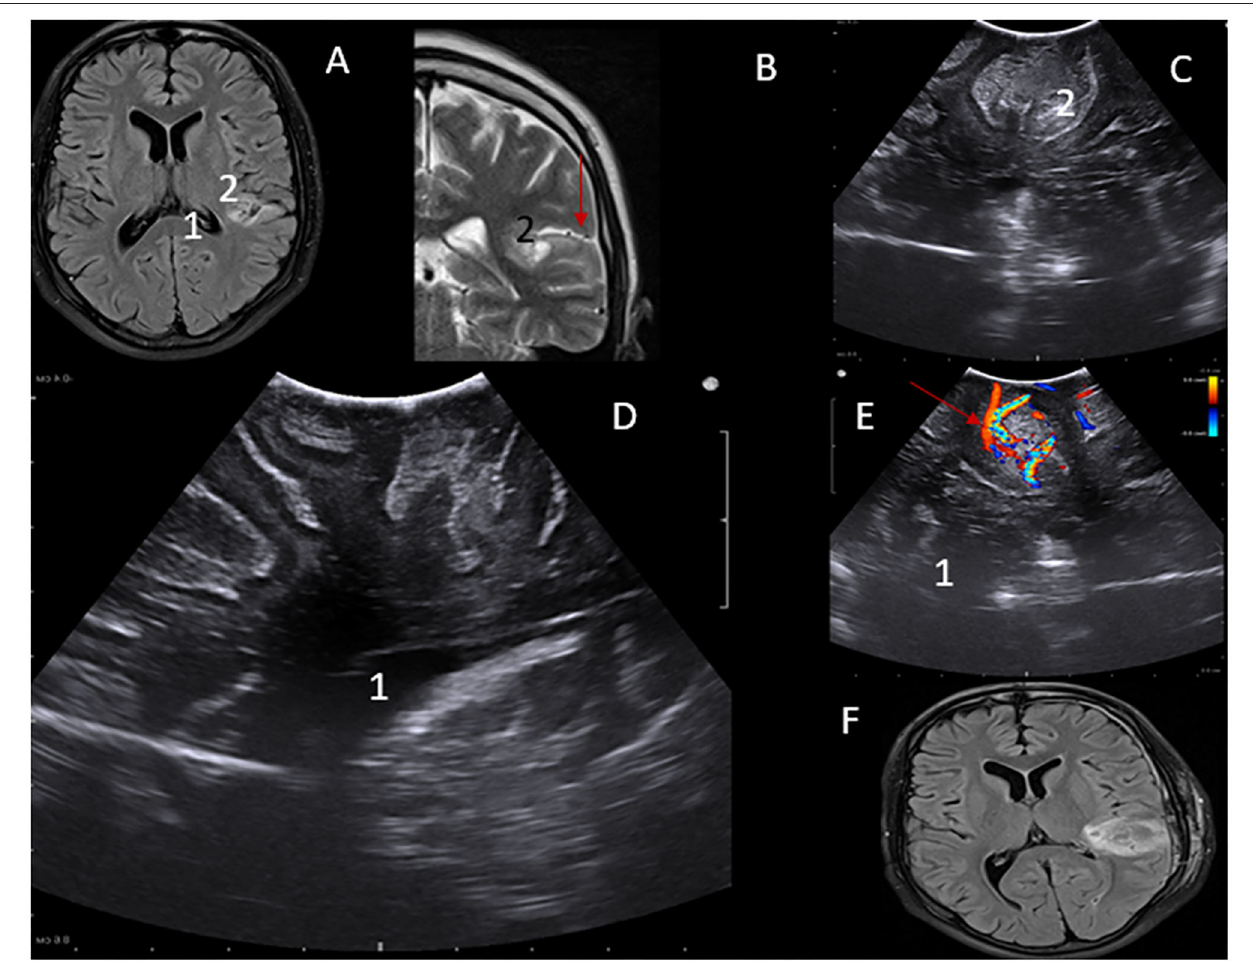
FIGURE 3 | (A) MRI – flair axial view of Lt parital lobe lesion- 1. (B) MRI – T2WI MRI coronal view of Lt parietal lobe lesion- 2. iUS depiction of low-grade lesion in axial. (C,D) Saggital views Perilesional vascular structures can be visualized using Color Doppler function-Red arrow (A,E) . Post-operative MRI showing gross total resection of the lesion (F)